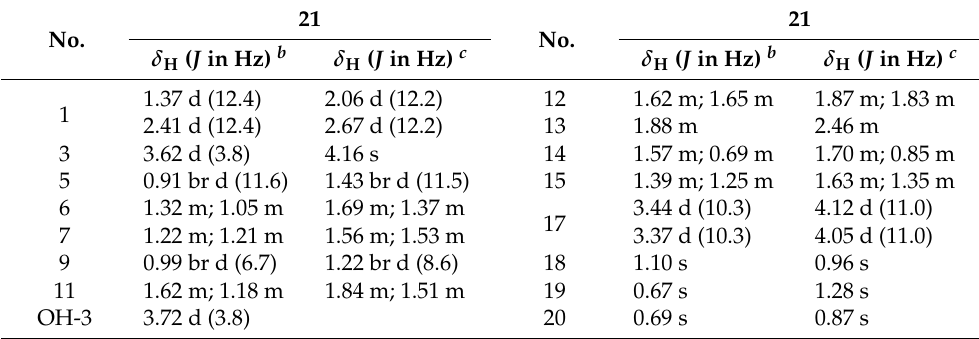
Table 3. 1 H ( δ in ppm, 600 MHz) and 13 C ( δ in ppm, 150 MHz) NMR data a of 21 . No.